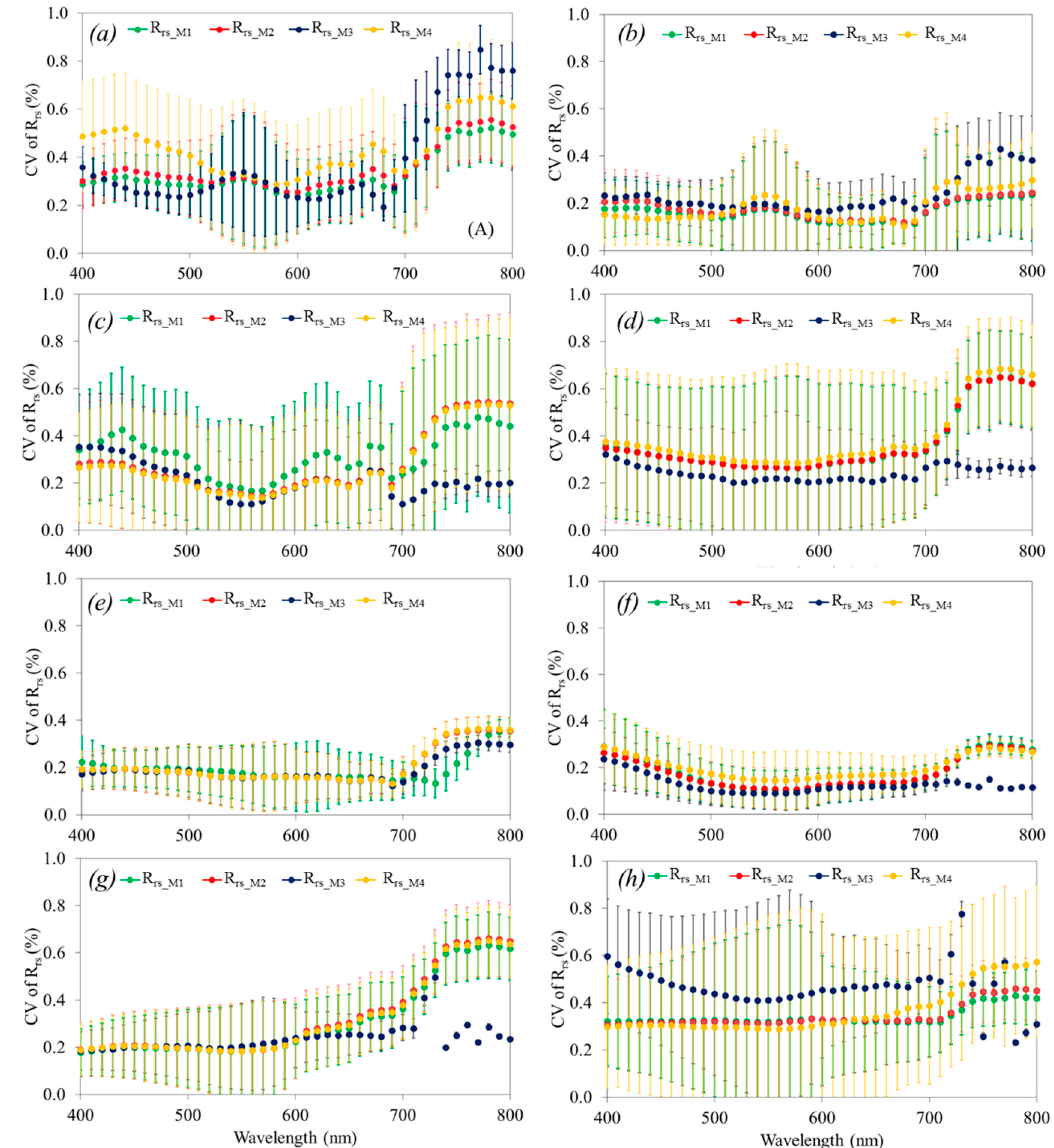
Figure 5. Coefficient of variation (CV) of R rs derived from glint removal methods M1 [7], M2 [8], M3 [5], and M4 [9] in ( a ) BB1, ( b ) BB2, ( c ) BAR1, ( d ) BAR2, ( e ) IBI1, ( f ) IBI2, ( g ) NAV1, and ( h ) NAV2. The error bars indicate the standard deviation (SD, sr − 1 ) from each fieldwork rescaled by a factor of 100 (SD × 100).